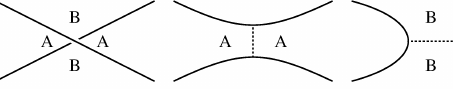
with w.D/ being the writhe of D (see subsection 2.2